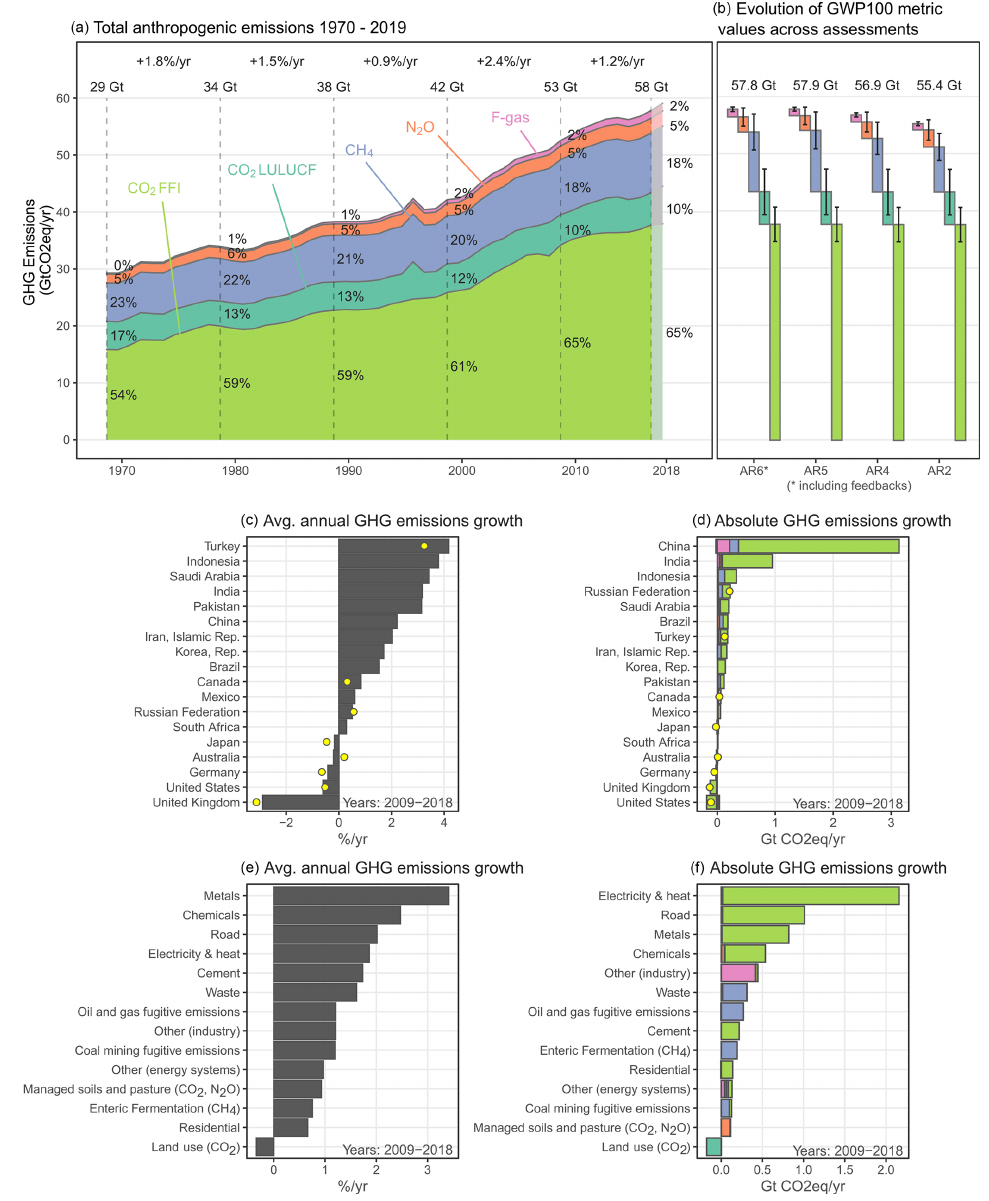
Figure 8. Total anthropogenic GHG emissions (GtCO 2 eq . yr − 1 ) for 1970–2018 and initial estimates for 2019 as well as country and sector contributions to changes over the last decade (2009–2018): CO 2 -FFI (light green); CO 2 -LULUCF (dark green); CH 4 (blue); N 2 O (orange); fluorinated gases (pink); all GHGs (black). Gases are reported in GtCO 2 eq . converted based on global warming potentials with a 100-year time horizon (GWP-100) from IPCC AR6 (Forster et al., 2021). (a) Aggregate GHG emissions trends for 1970–2018 with the initial 2019 estimate. Average annual growth rates by decade are reported at the top of the figure (in %yr − 1 ). Transparent colour for the 2019 estimate indicates its preliminary nature and lower confidence associated with it. (b) Waterfall diagrams juxtapose GHG emissions for 2018 in CO 2 eq . units using GWP-100 values from the IPCC’s AR6, AR5, AR4, and AR2, respectively. Error bars show the associated uncertainties at a 90% confidence interval (see Sect. 3). Panels (c) and (d) show relative (in %yr − 1 ) and absolute (in GtCO 2 eq . yr − 1 ) average annual changes in GHG emissions for a selection of the largest emitting countries (contributing 75% of global GHG emissions in 2018), excluding CO 2 - LULUCF emissions as uncertainties in our estimates are too high for country-level reporting. The yellow dots represent the emissions data from UNFCCC-CRFs (2021) that were accessed through Gütschow et al. (2021a). Further comparisons with CRF data are provided in Figs. S3 and S4. Panels (e) and (f) show relative (in %yr − 1 ) and absolute (in GtCO 2 eq . yr − 1 ) changes in GHG emissions for a selection of the largest emitting sectors (see Table 2) (contributing 90% of global GHG emissions in